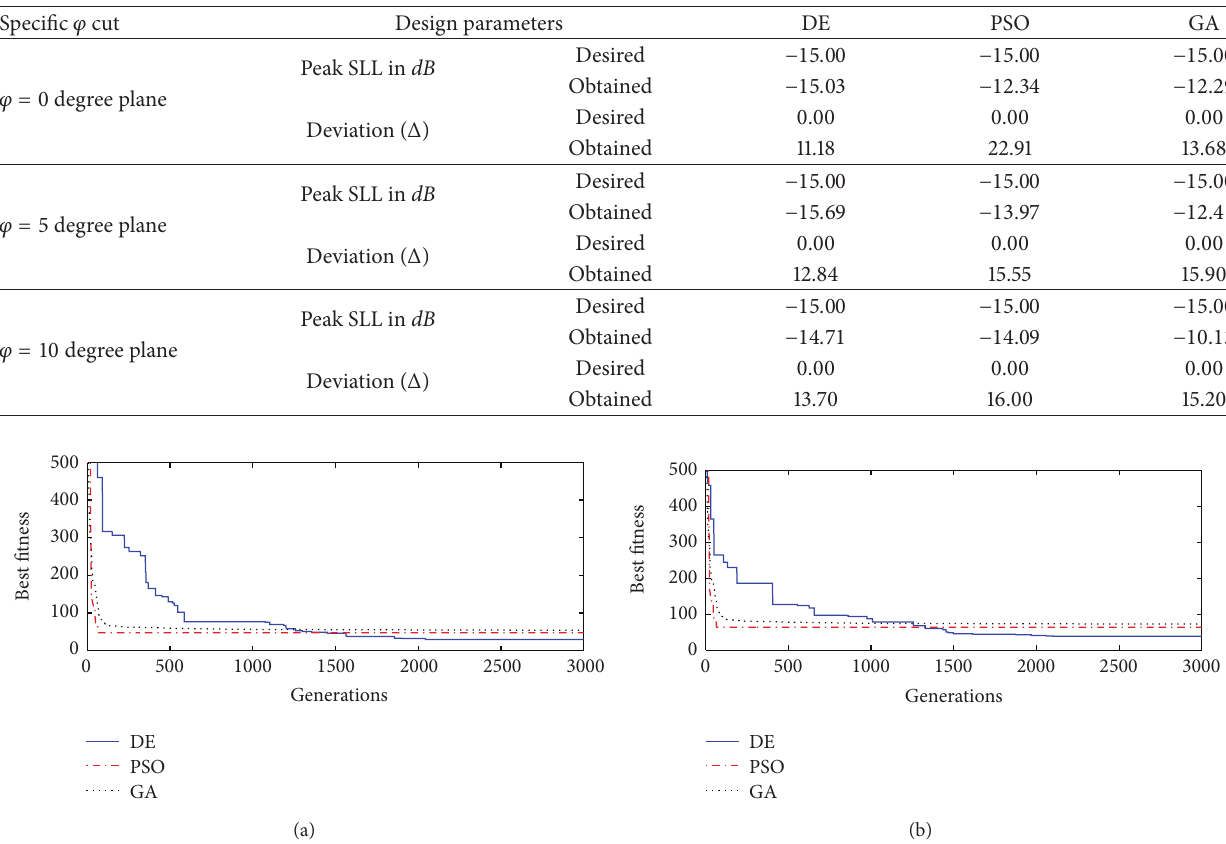
Figure 8: Convergence characteristics of DE, PSO, and GA: (a) for Case I of the design problem (b) and for Case II of the design